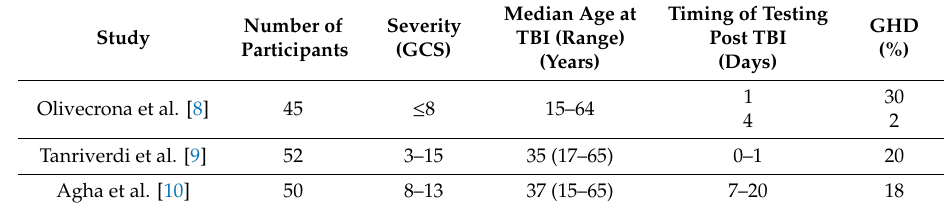
Table 1. Prevalence of growth hormone deficiency occurring within one month of traumatic brain injury.